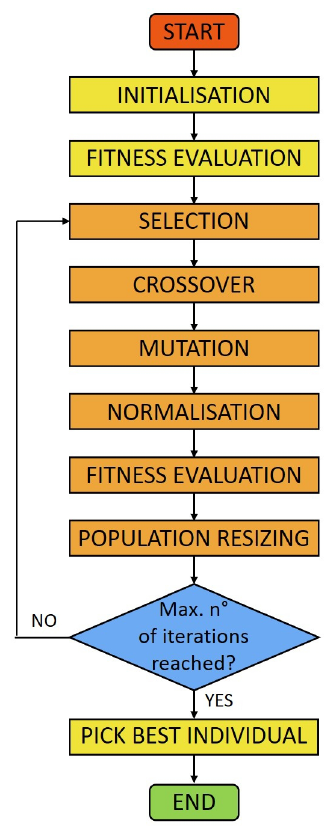
Figure 2. Flowchart of the GA used in this work.